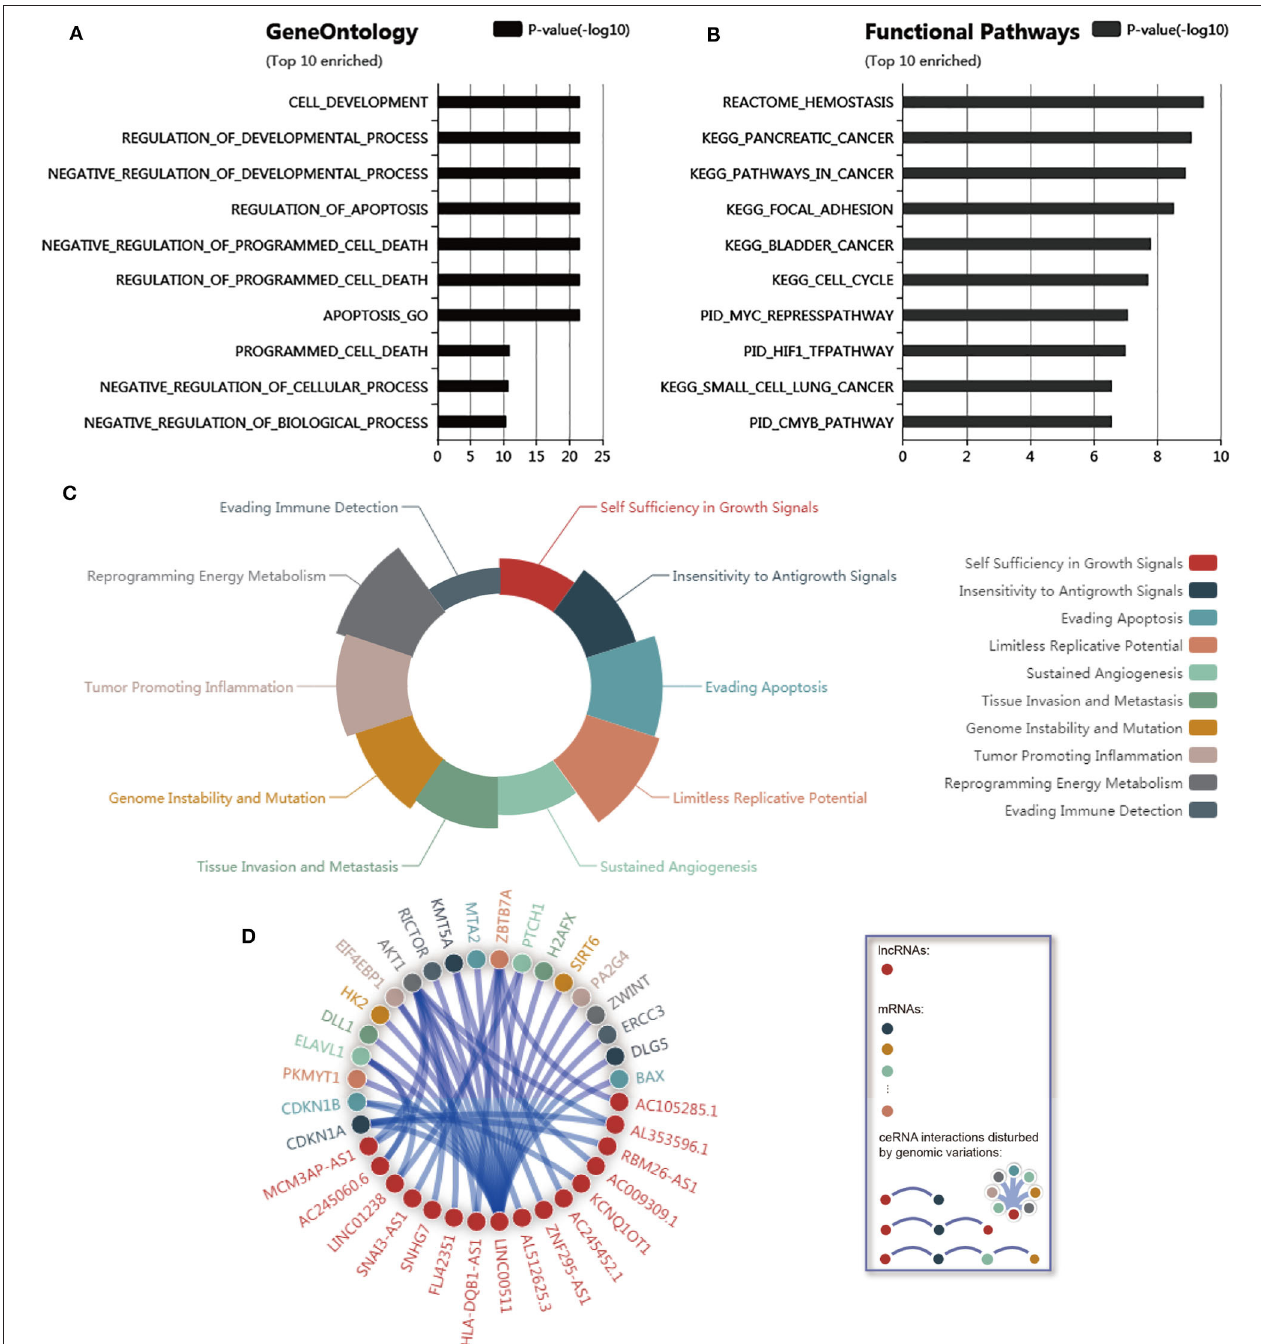
FIGURE 5 | Correlation analysis of LINC00511. (A) Top 10 enriched gene ontology of LINC00511. (B) Top 10 enriched functional pathways of LINC00511. (C) Dysregulated hallmarks of variation-ceRNA event. (D) Related ceRNA network of LINC00511 disturbed by variation. Results from GEPIA were highly consistent with those